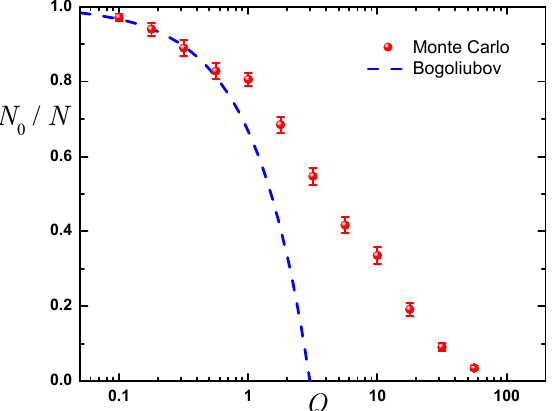
Figure 3. Condensate fraction as a function of Q . Symbols report Monte Carlo data; dashed line shows the Bogoliubov theory prediction given by Equation